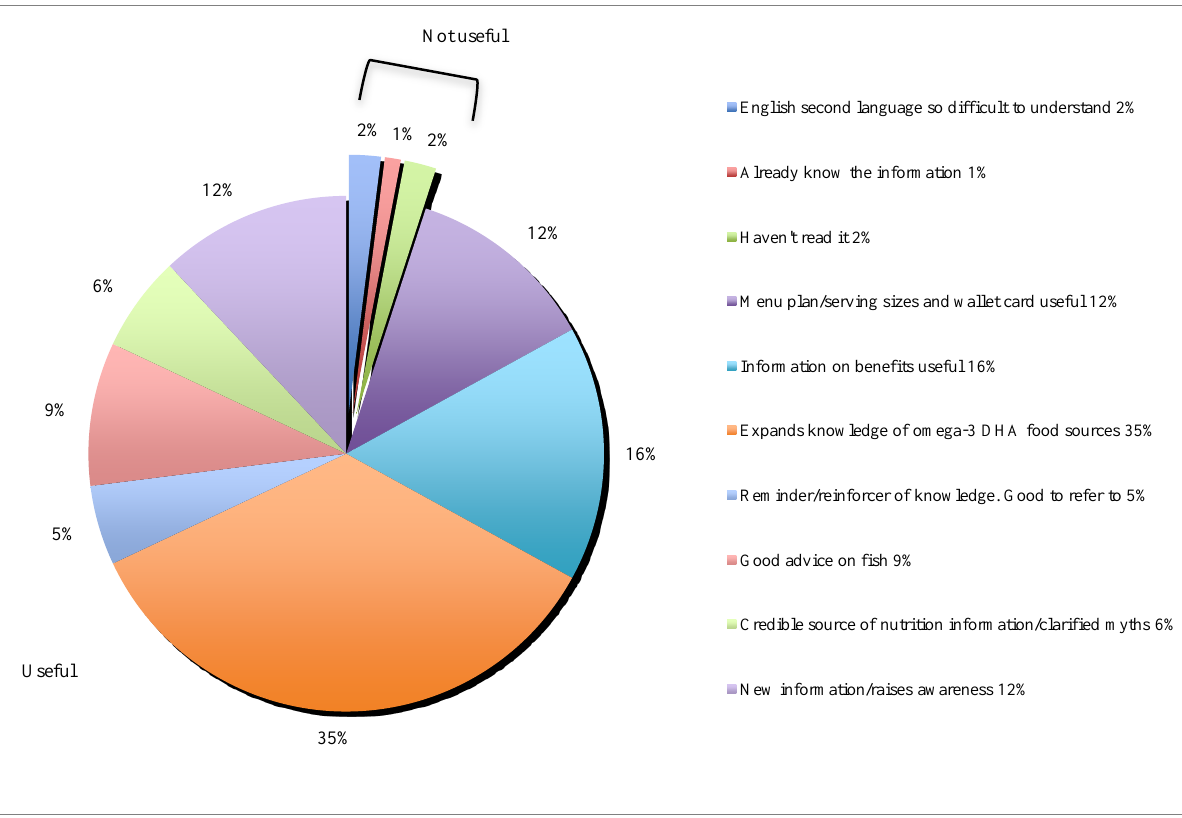
Figure 1. Reasons women found the DHA pregnancy education pamphlet and card useful or not useful. The reasons reported were of qualitative nature and have been grouped into common themes; these themes are displayed in the